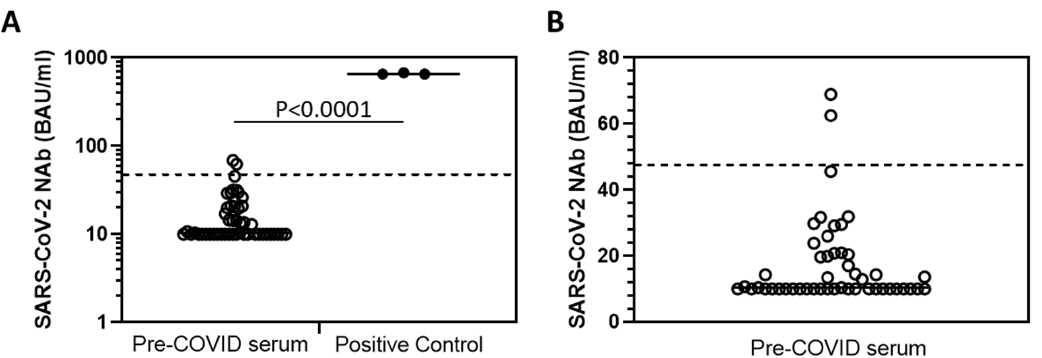
Figure 4. Scatterplots of NAb determination by TRFIA of Pre-COVID-19 serum samples (triplicate) to determine specificity and positive/negative cut-off value (dotted horizontal line = 47.58 BAU/mL). ( A ): displays scatter of Pre-COVID-19 serum data with respect to positive control (high NIBSC standard), significantly different p < 0.0001. ( B ): displays scatter range in values of Pre-COVID-19 serum data alone.